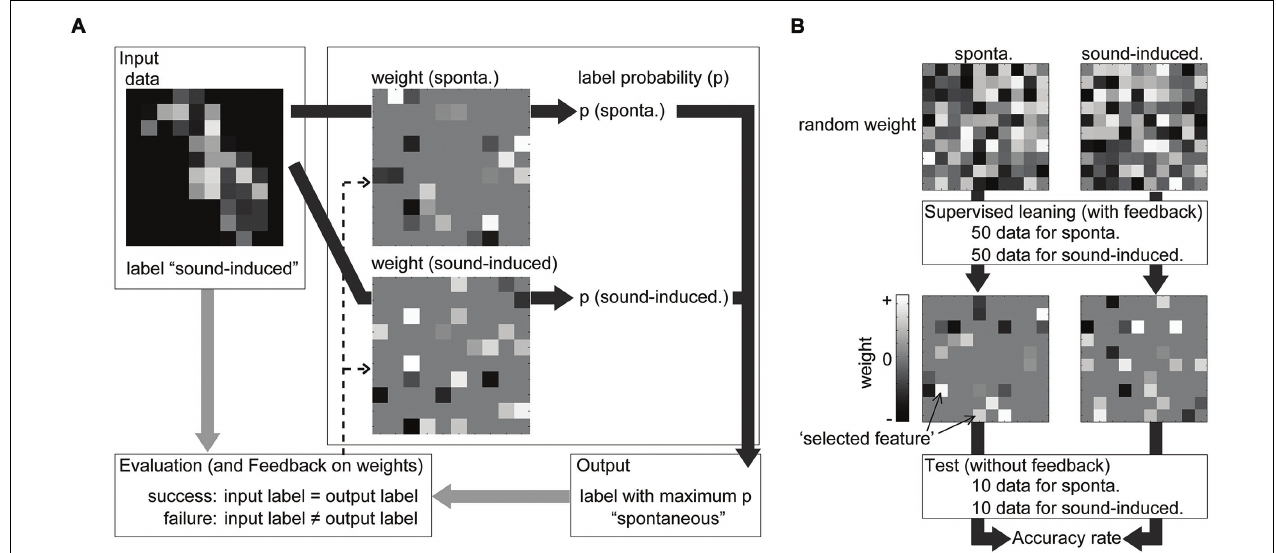
FIGURE 4 | Discrimination by SLR during supervised learning and the subsequent testing process. (A) From one input, SLR calculated and compared label probability (indicated by deep gray arrows). SLR had weight vectors equal to the tested label (in this figure, two labels) and the input value at each recording site was multiplied with the weight at the same recording site. From the summation of this multiplication of the input data and weight vectors, the softmax function calculated the ‘label probability (p)’ for each label. SLR then determined the label with the maximum label probability as the output label or discrimination result. In supervised learning, SLR renewed the weight vector (indicated by the dotted arrows) according to the comparison between the input and output label (indicated by light gray arrows). (B) The discrimination consisted of two steps: supervised learning and the testing process. After supervised learning, SLR again discriminates new samples and we obtained the accuracy rate of the discrimination and weight vector for each label.